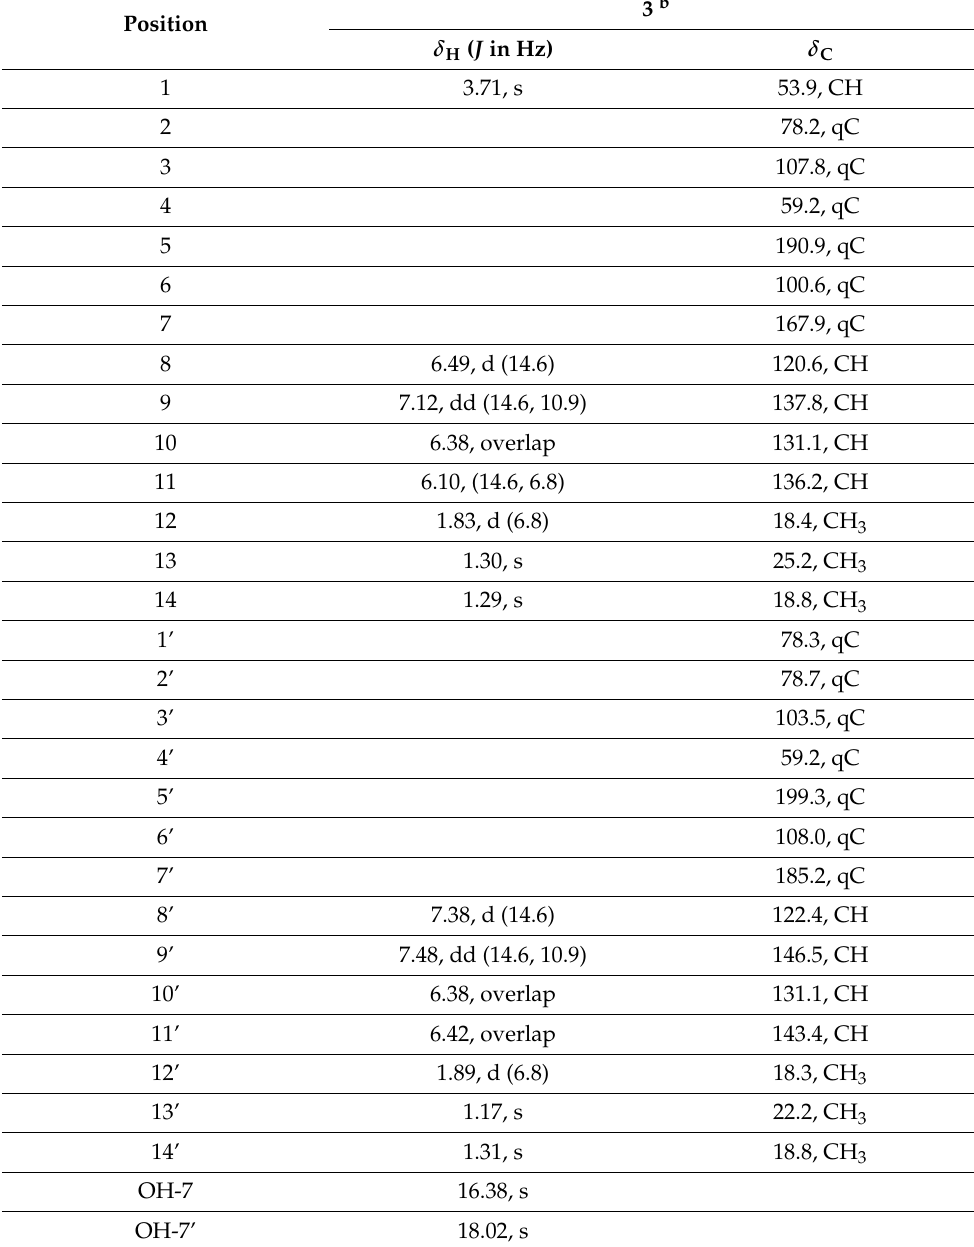
Table 2. 1 H NMR (500 MHz) and 13 C NMR data (125 MHz) for 3